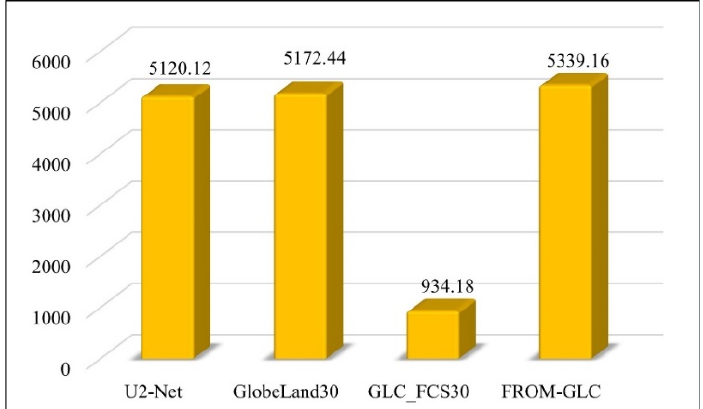
Figure 16. Coniferous forest areas of Northwest Liaoning in 2010 calculated from U 2 ‐ Net and three datasets (GlobeLand30, GLC_FCS30, FROM ‐ GLC).